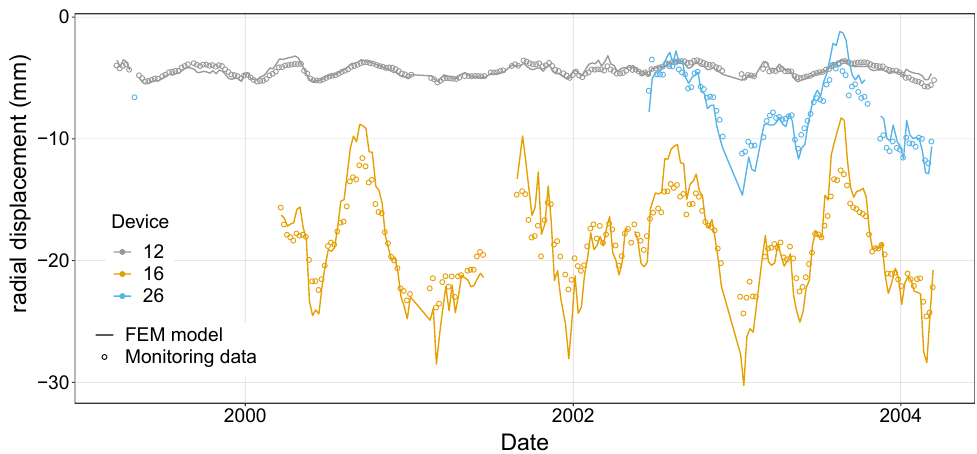
Figure 4. Comparison between the observed radial displacements in stations 12, 16 and 26 and the results of the numerical model of Scenario